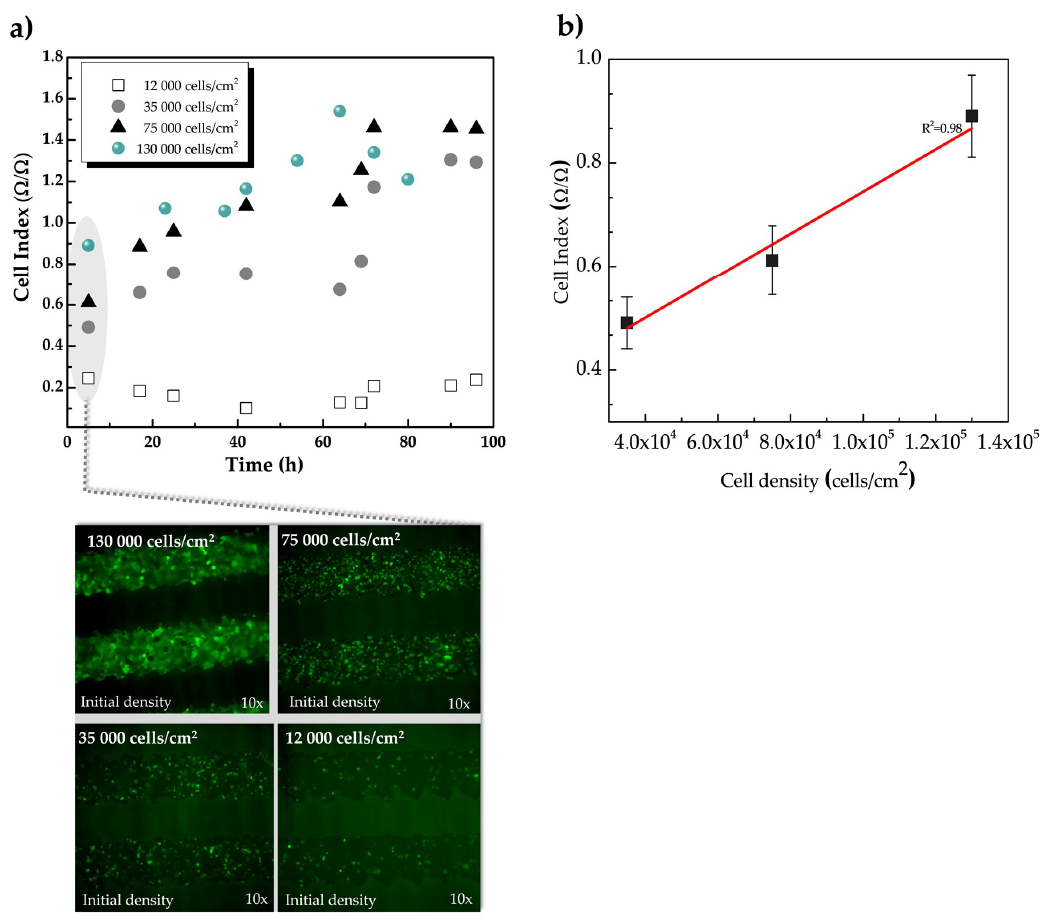
Figure 5. Monitoring of proliferation and determining detection limits of the sensor at 100 Hz. ( a ) Cell index values versus time in hours for real-time impedance monitoring of HaCaT-GFP cell adhesion and proliferation over 96 h. Cells were seeded at di ff erent initial densities (12,000 cells / cm 2 ; 35,000 cells / cm 2 , 75,000 cells / cm 2 and 130,000 cells / cm 2 ) on collagen-coated inkjet-printed IDEs. The higher the initial cell densities, the higher the cell index obtained. For the initial cell densities of 75,000 cells / cm 2 , the maximum cell index value is reached at around 72 h, indicating cell confluence in the culture. For low initial cell density (12,000 cells / cm 2 ), the measurements are significantly lower than the other cultures, remaining low even after 69 h, and slowly increasing after that. For the highest initial cell density (130,000 cells / cm 2 ), the maximum cell-index value is detected around 60 h, sharply decreasing in the following measurements. As cultures with di ff erent cell densities initially seeded have di ff erent growth rates, the maximum cell index is expected to be detected at di ff erent time points, which is verified in the cell index curve. ( b ) Cell index linearly correlated with the number of cells initially seeded on the sensors between 35,000 and 130,000 cells / cm 2 at 17 h after seeding. (error bar represents the standard deviation, n = 3). As cell index of the cultures with the lowest cell densities (i.e., 12,000 cells / cm 2 ) remained low along with 69 h, such values were not included to analyze the correlation between initial cell densities and the cell index, as we assumed that was below the sensitivity limit of the